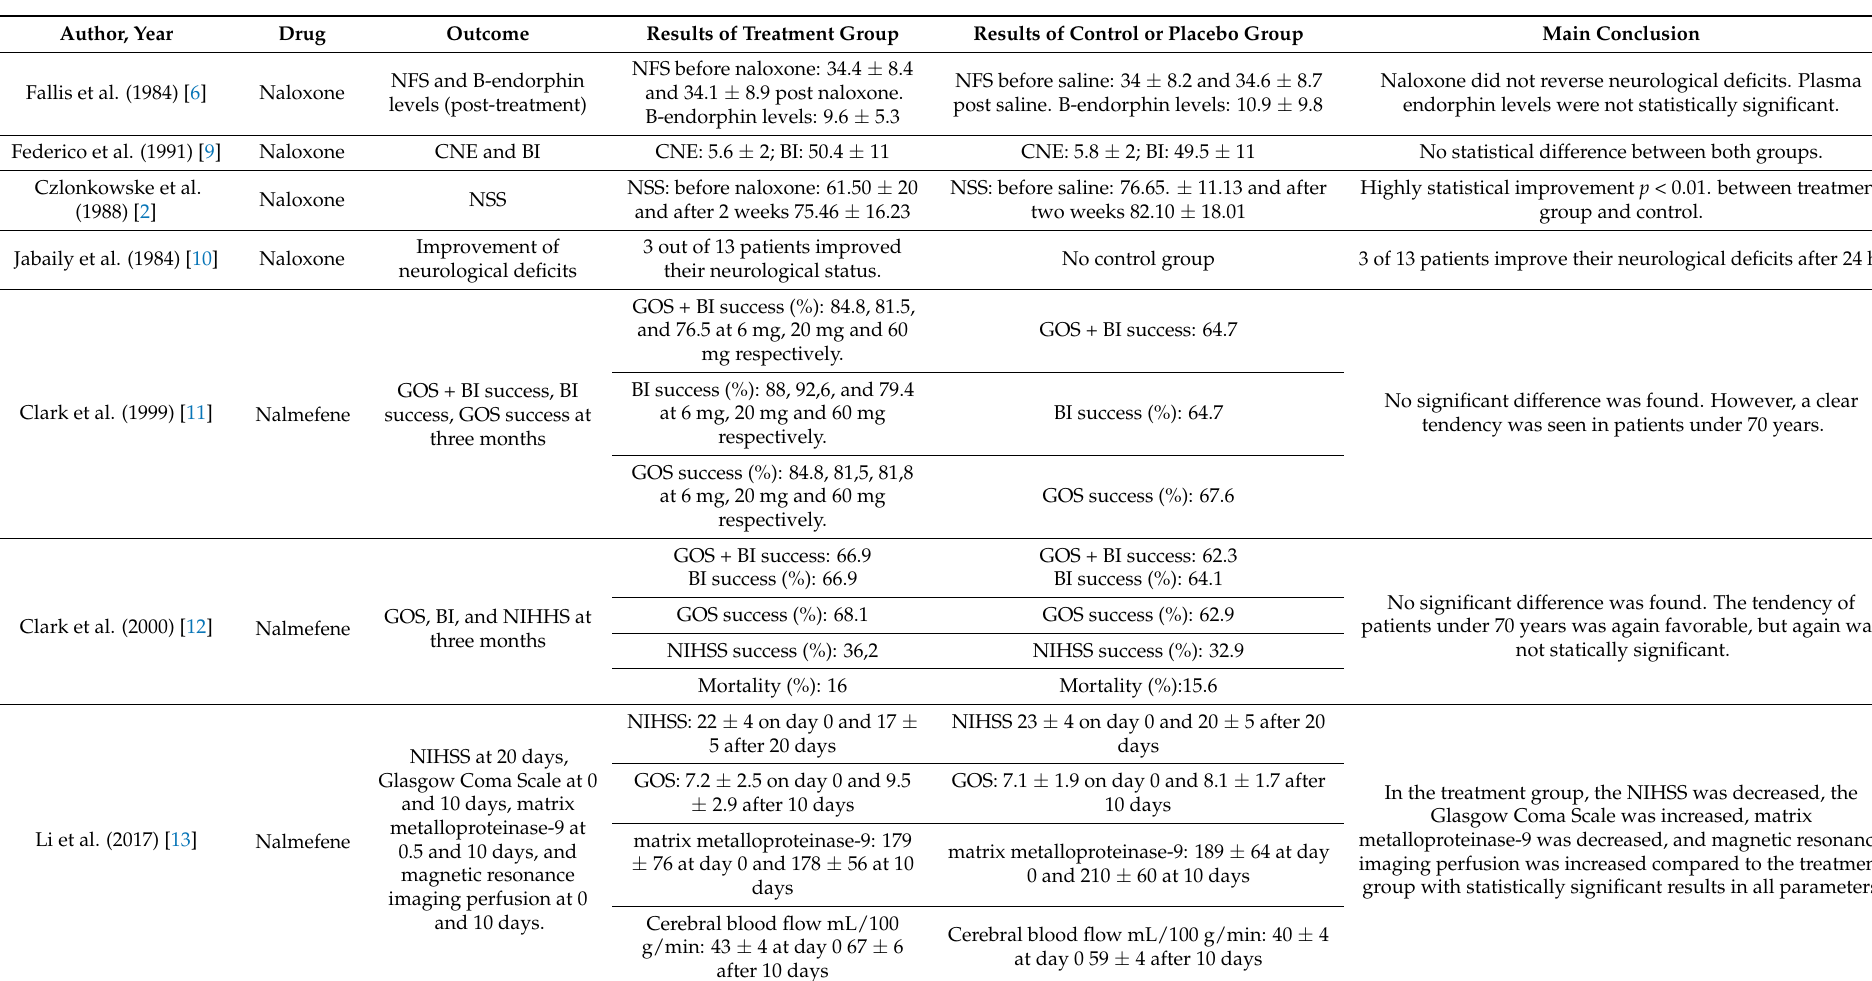
Table 2. Outcomes and conclusions of the clinical